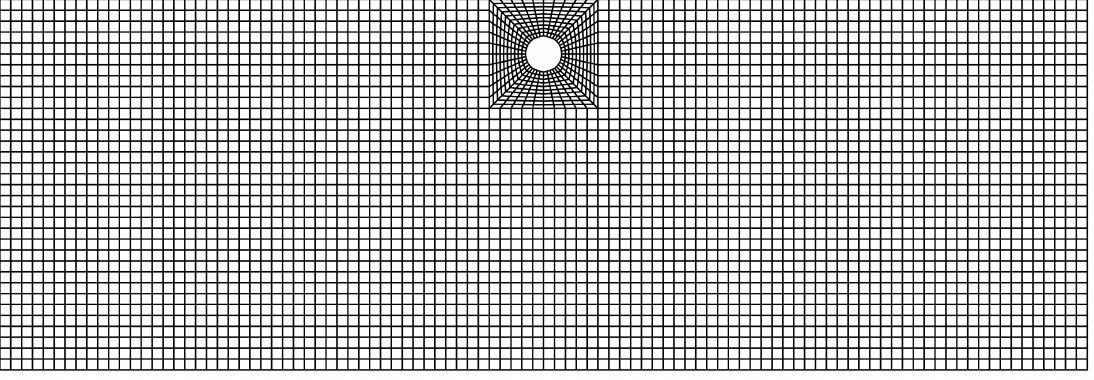
Figure 4. Mesh system of the calculation with a pipeline (400 non-rectangular elements with in the rectangle zone of the pipeline nearest proximity, and 3300 square elements outside the rectangle